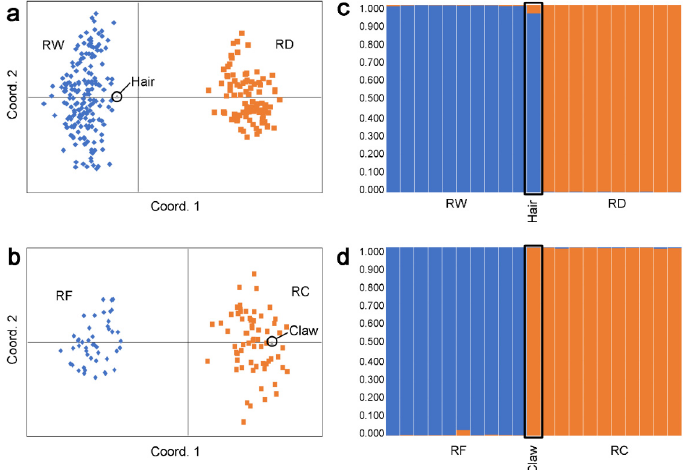
Figure 1. Multivariate and Bayesian assignment of multilocus genotypes obtained from the hair and claw samples to their respective belonging populations. Left side: graphical plotting of the Principal Coordinate Analysis performed in GenAlEx assigning ( a ) the hair sample genotype (grey triangle) to the cluster of the reference wolf (RW, blue) or dog (RD, orange) populations; ( b ) the claw sample genotype (grey triangle) to the cluster of the reference wildcat (RF, blue) or domestic cat (RC, orange) populations. Right side: Bayesian clustering histograms produced by Structure assuming K = 2 clusters and with the “admixture” and “I” models of the ( c ) hair genotype determined at 39 microsatellite loci and assigned to the reference wolf (RW, blue) or dog (RD, orange) populations and ( d ) claw genotype determined at 29 microsatellite loci and assigned to the reference wildcat (RF, blue) or domestic cat (RC, orange) populations. Each individual is represented by a vertical bar fragmented into the two-coloured sections, according to their proportion of membership to the reference population clusters. For a better readability, only ten genotypes for each reference population were shown as bar plots obtained from Bayesian assignment